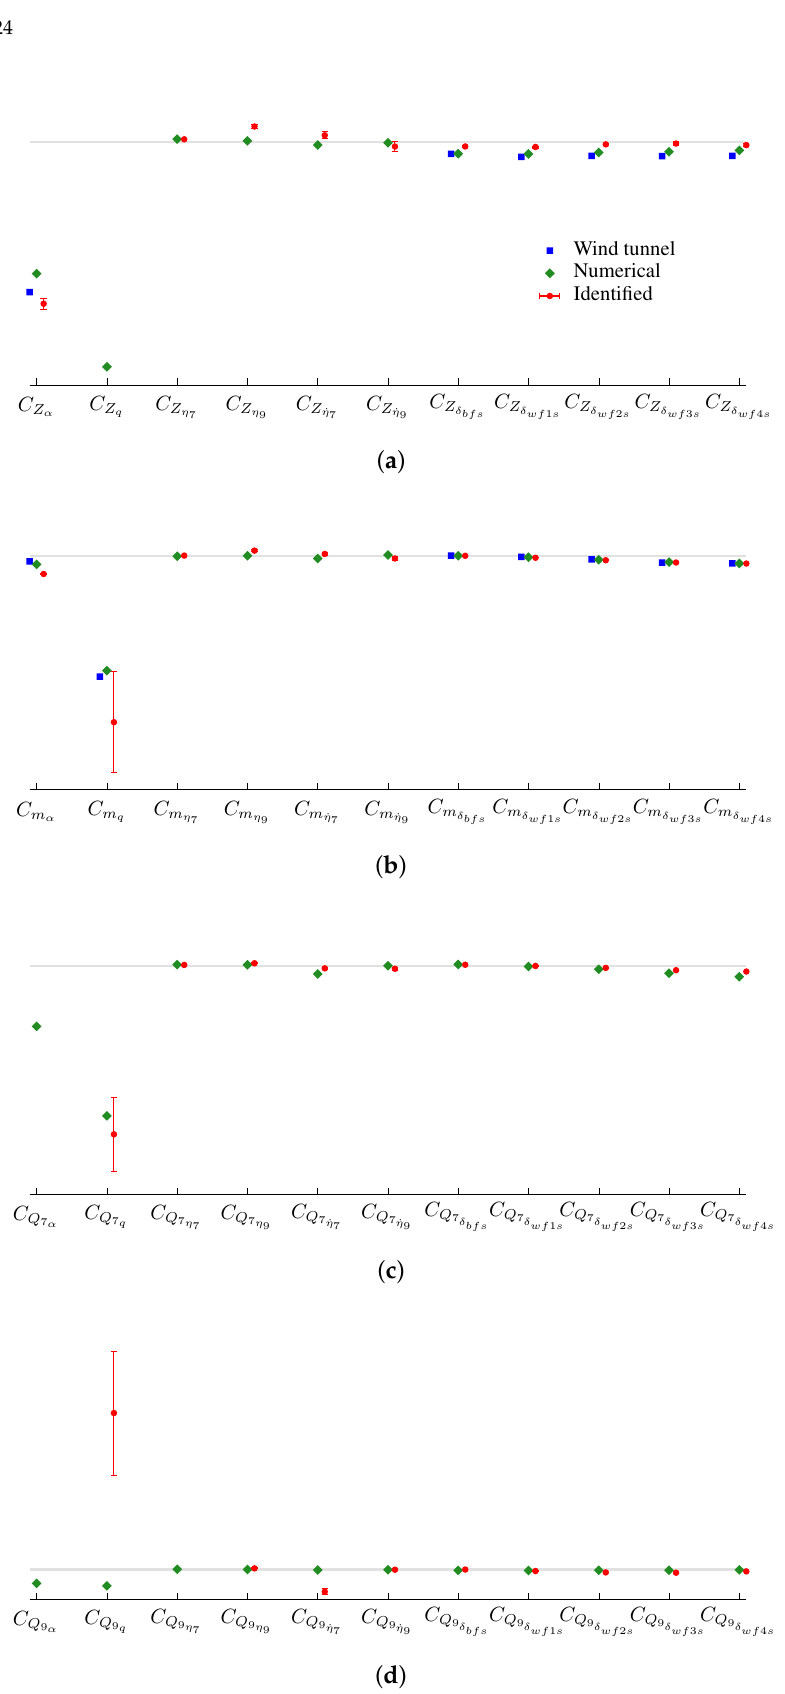
Figure 6. Estimated stability and control derivatives identified from wind tunnel tests with a scaled half-span model (blue), an aeroelastic panel code (green), and flight test data (red): ( a ) vertical force C Z derivatives; ( b ) pitching moment C m derivatives; ( c ) first symmetric wing bending C Q derivatives; 7 and ( d ) first symmetric wing torsion C Q 9